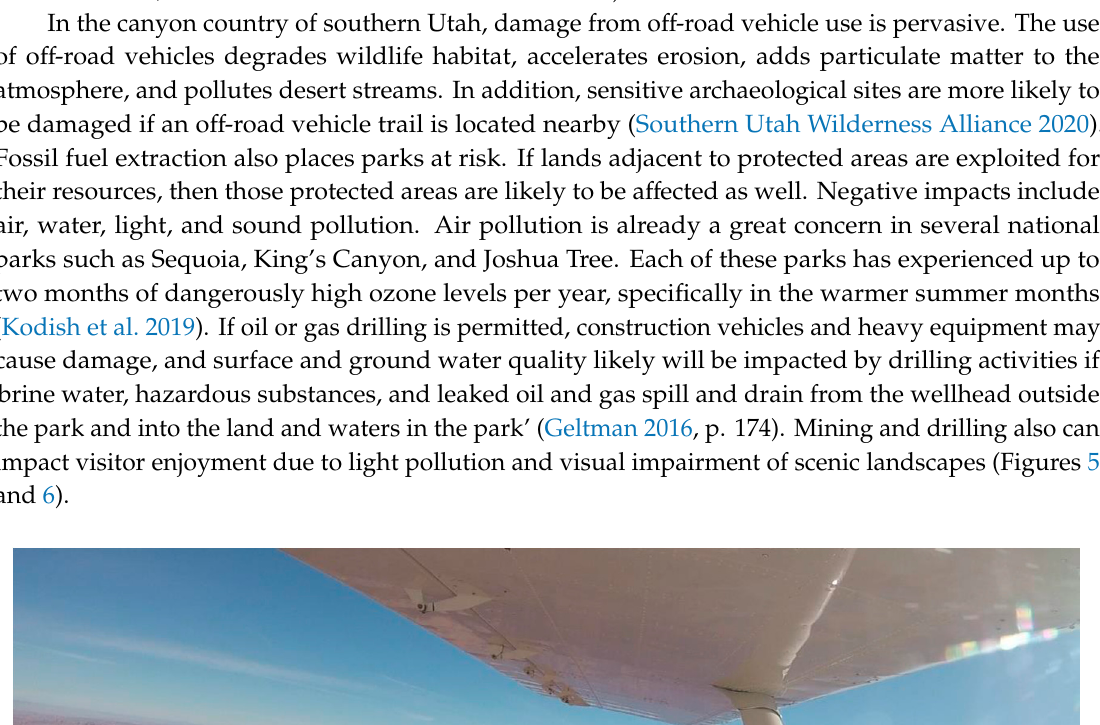
Figure 6. Oil rig near Canyonlands. Just north of park boundaries, and on some of the approach roads, oil rigs can be observed. Photograph by Tatyana Martello, November 2018. 5. Creating Canyonlands National Park Three men, in particular, figured prominently in the creation of CANY: Kent Frost, Bates Wilson, and Stewart Udall. Frost, a local outfitter and guide, first introduced Wilson to the region in the 1950s (Prettyman 2014). Nicknamed the “father of Canyonlands,” Wilson became a strong advocate for the creation of a new national park, taking reporters, scouts, and film crews on tours of the area and eventually becoming the park’s first superintendent (Prettyman 2014). In 1961, Udall joined Wilson in the cause for a new national park in the Canyonlands region. He first viewed the